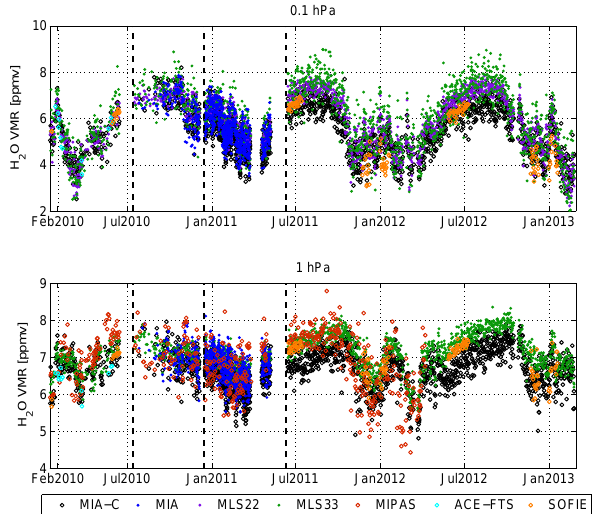
Fig. 7. Overview of the data used for the intercomparison on two pressure levels. The black dashed vertical lines indicate the begin- ning of a new comparison period. Some of the satellite data are convolved with MIAWARA-C’s averaging kernels, and only data points fulfilling the coincidence criterion are shown (see Sect. 4.1). In April 2011 there is a gap in Aura MLS’s measurements which is also present in MIAWARA-C and MIAWARA data because of missing temperature